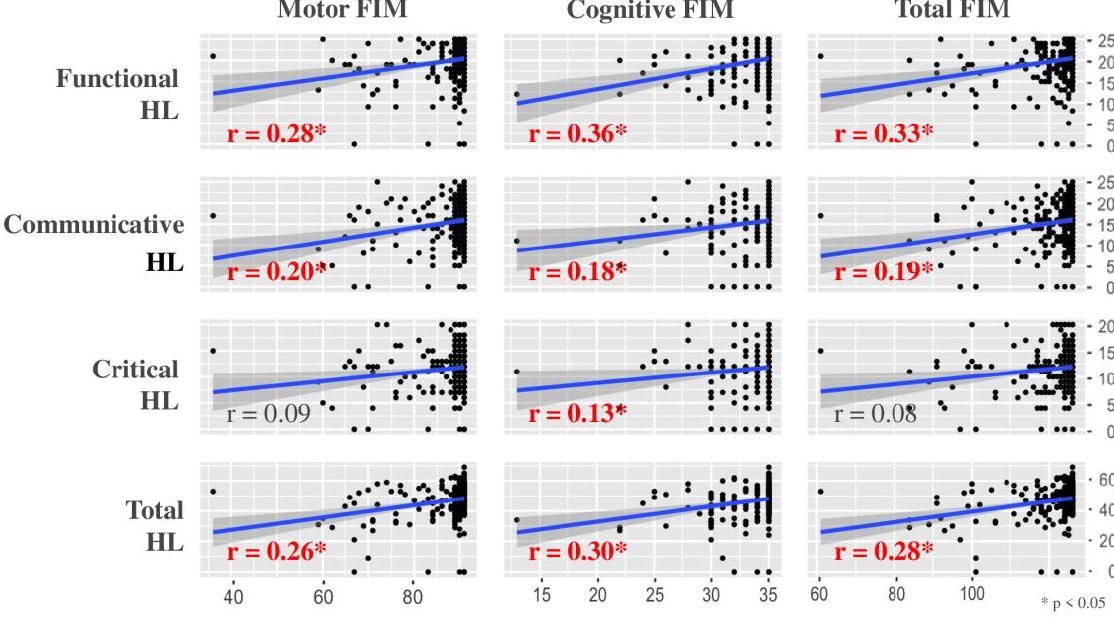
Figure 2. Correlation between health literacy (HL) and the Functional Independence Measure (FIM) .